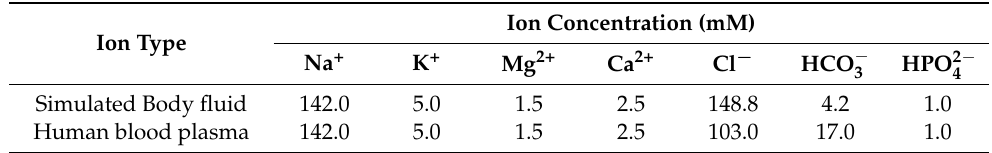
Table 1. Ion concentration in SBF and human blood